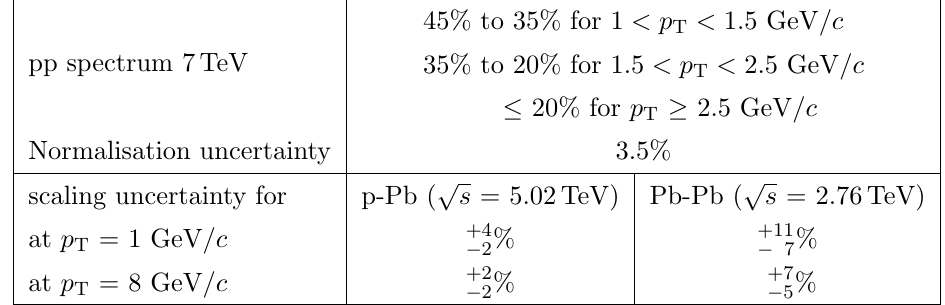
Table 3 . Systematic uncertainties of the p T -di(cid:11)erential cross section of electrons from beauty- p hadron decays measured at s = 7 TeV [23], the normalisation uncertainty, as well as the scaling p p uncertainties for the reference spectra at s = 5.02 TeV and s = 2.76 TeV. The scaling uncer- tainties for the reference spectra are slightly p T dependent; the uncertainties are given for the two extreme p T intervals. Details are described in the text.